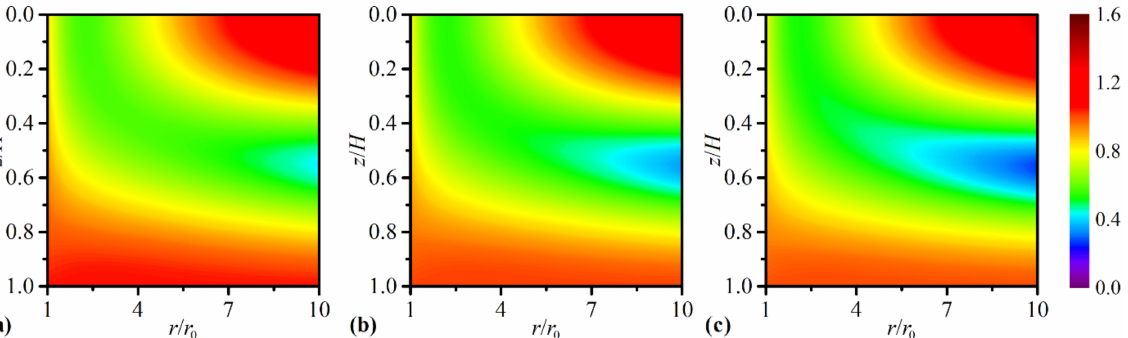
Figure 8. The effects of the disturbance degree ( η ) on the soil displacements ( ρ p = 2500 kg/m 3 , E p = 36 GPa, r 0 = 0.5, υ j = 0.4, β j = 0.2, G N +1 = 36 MPa, H = 20 m). ( a ) η = 0.5; ( b ) η = 1; ( c ) η =